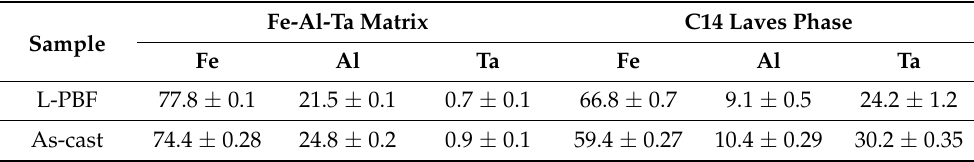
Figure 4. A 3D representation of the BSE-SEM microstructure of the L-PBF build printed using P = 250 W and vs. = 1000 mm/s. The arrows in a higher magnification image show a few (Fe, Al) 2 Ta C14 Laves phase precipitates formed along the matrix grain boundaries and within the grains. The BD and SD refer to the building and scanning direction. Table 3. The average concentration of elements in at. % within the Fe–Al–Ta matrix and (Fe, Al) 2 Ta Laves phase determined by EDX in the L-PBF and in the as-cast